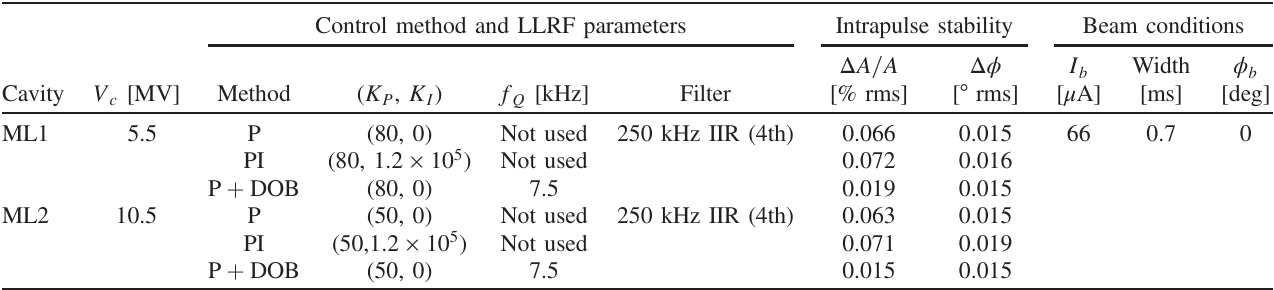
TABLE IV. Performance of DOB control in the beam-loading compensation during the cERL beam commissioning.